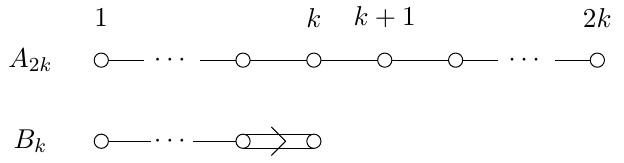
Figure 2 . Dynkin diagram A 2 k (Lie algebra su ( N = 2 k + 1) ) has a Z 2 outer automorphism, which flips the order of its nodes. Folding it by average yields the Dynkin diagram B its C -invariant subalgebra so (2 k + 1) . S